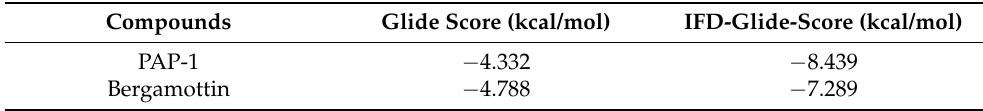
Table 4. Docking results of Bergamottin and PAP-1 with